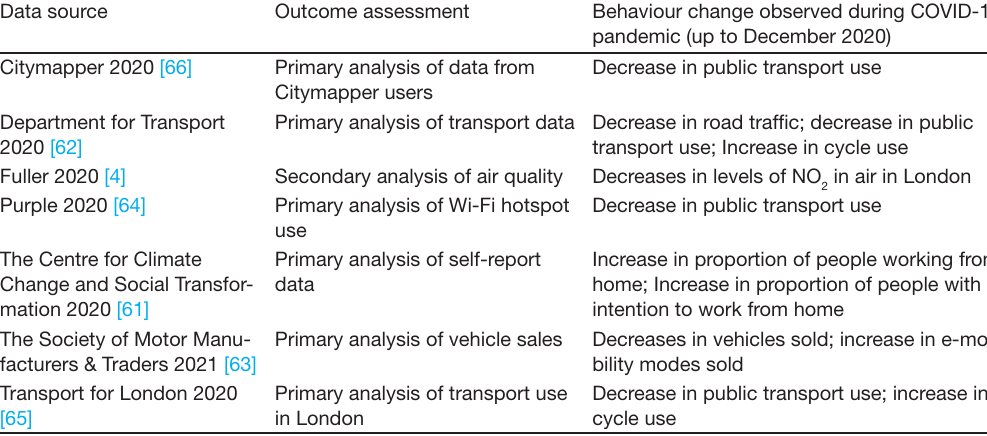
Table A3. Data sources for the UK case